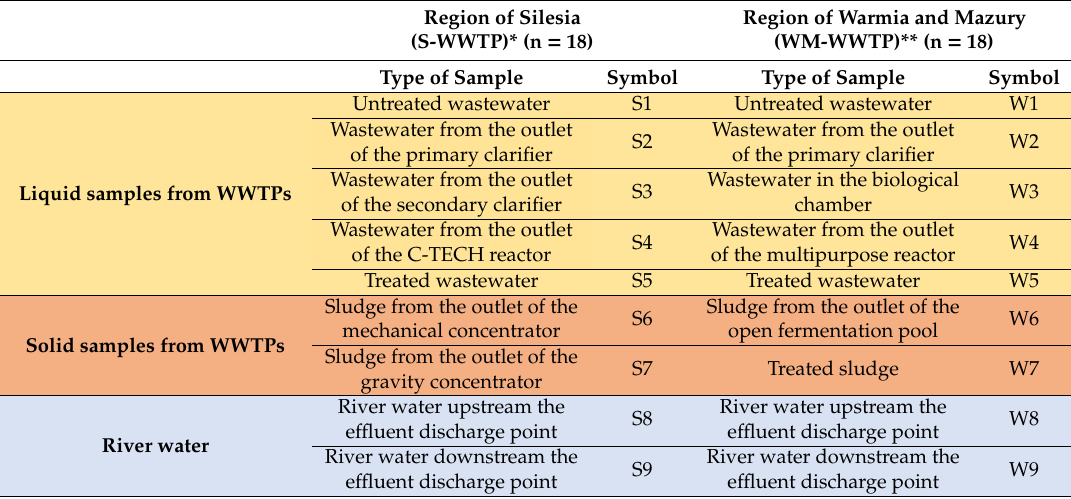
Table 1. Types of collected